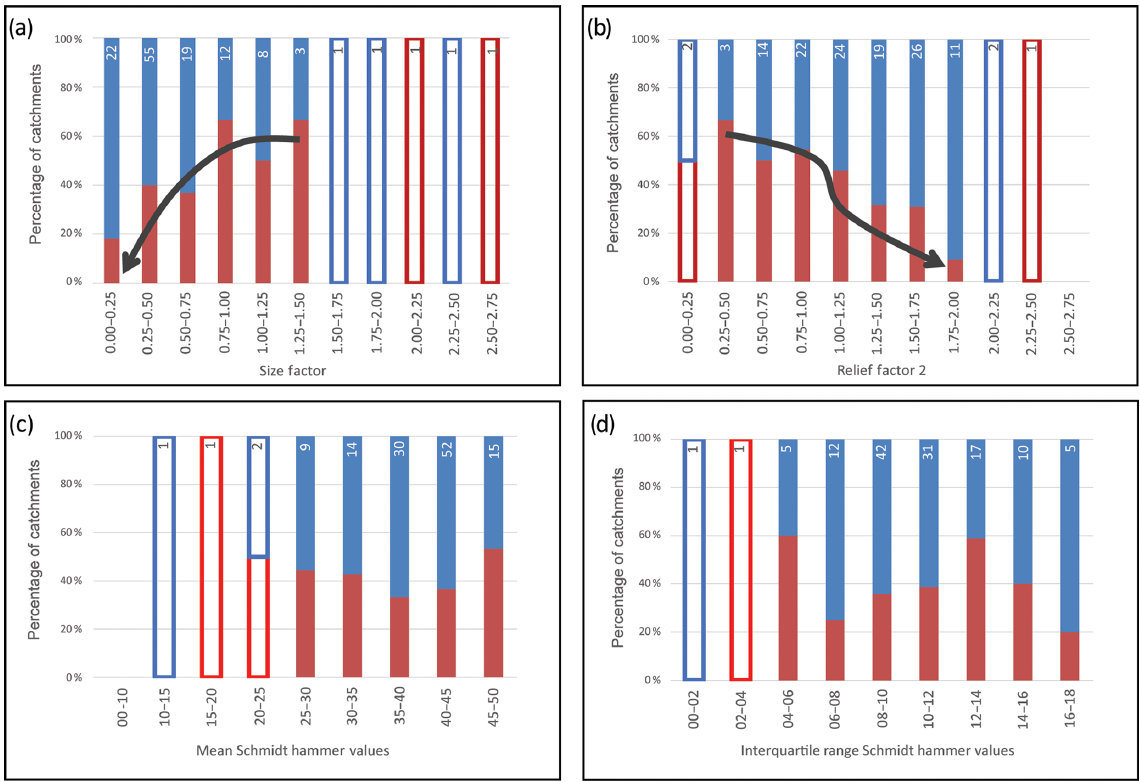
Figure 7. Histograms with the relative percentage of catchments with debris flow generation in red and nongeneration in blue considering range of values for (a) size factor, (b) relief factor, (c) normalized mean Schmidt hammer values and (d) normalized interquartile range Schmidt hammer values. Each bar includes a number indicating the quantity of analyzed catchments. Open bars indicate ranges without enough data to justify a statistical analysis (fewer than 5 catchments for range). Arrows indicate a trend in the